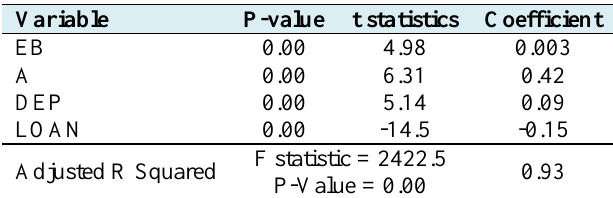
Table 2. Estimation Results of Model (1)